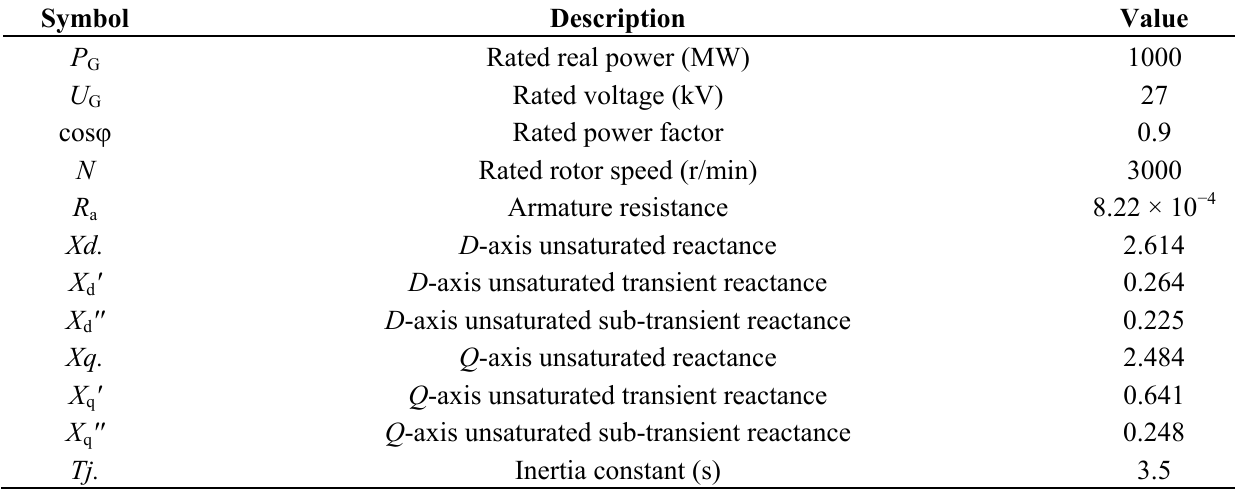
Table A3. Generator model parameters for PSCAD/EMTDC simulation.